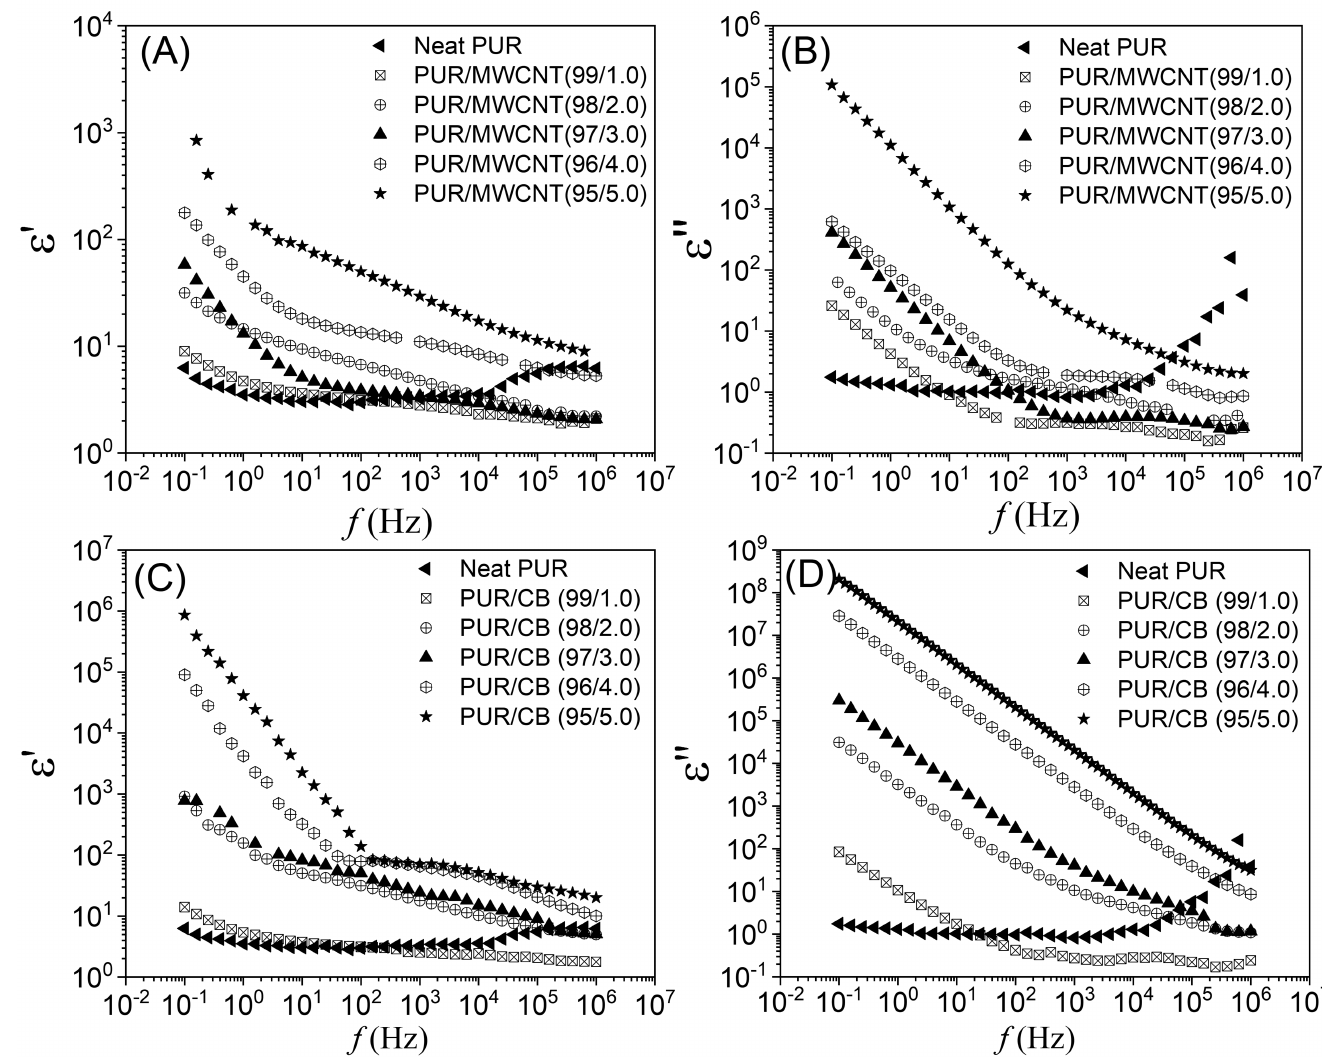
Figure 5. Complex dielectric constant, as a function of frequency for ( A , B ) PUR/MWCNT and ( C , D ) PUR/CB, with different mass fractions of the conductive